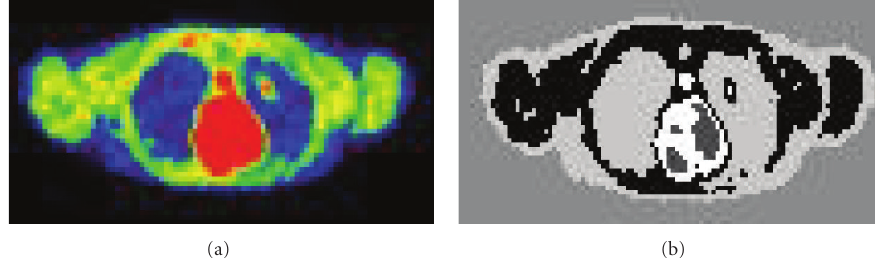
Figure 5: Simulated phantom data set (tumour 1): (a) original PET and (b) classified image.